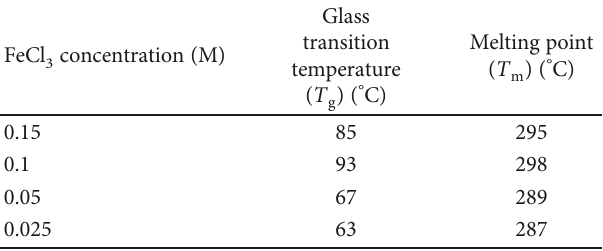
and (NH ) S O 3 4 2 2 8